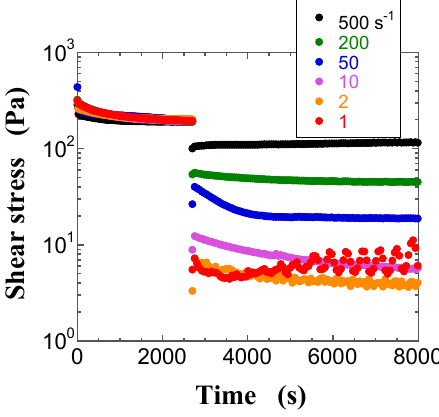
Figure 3. Plots of the transient shear stress for the FS suspension at φ = 0.017 at the shear rates of 1 s − 1 (filled red circle), 2 s − 1 (filled orange circle), 10 s − 1 (filled purple circle), 50 s − 1 (filled blue circle), 200 s − 1 (filled green circle), and 500 s − 1 (filled black circle) as a function of time.